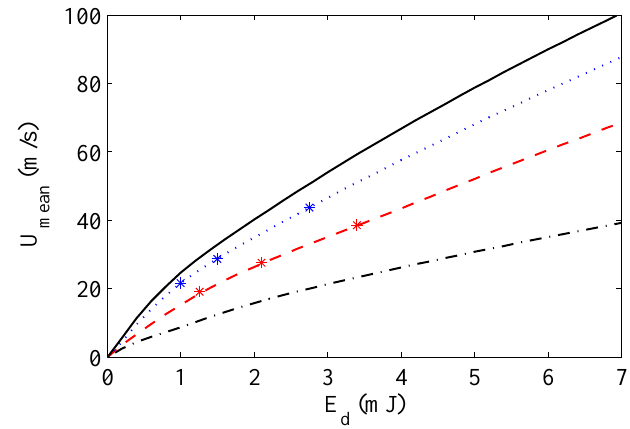
Figure 6. Variation of the mean jet velocity (Pitot tube measurements) with the discharged energy for different actuation frequencies. Black solid line refers to f = 1000 Hz, blue dotted line to f = 750 Hz, red dashed line f = 500 Hz, black dashed-dotted line to f = 250 Hz. Star markers represent experimental